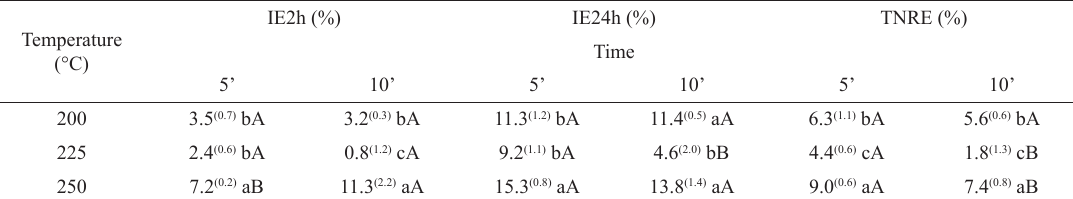
Table 6: Deployments of average values of thickness swelling after two and twenty-four hours and the rate of no return in thickness based on the time and temperature of the thermal treatment of MDF. IE2h Temperature (°C)